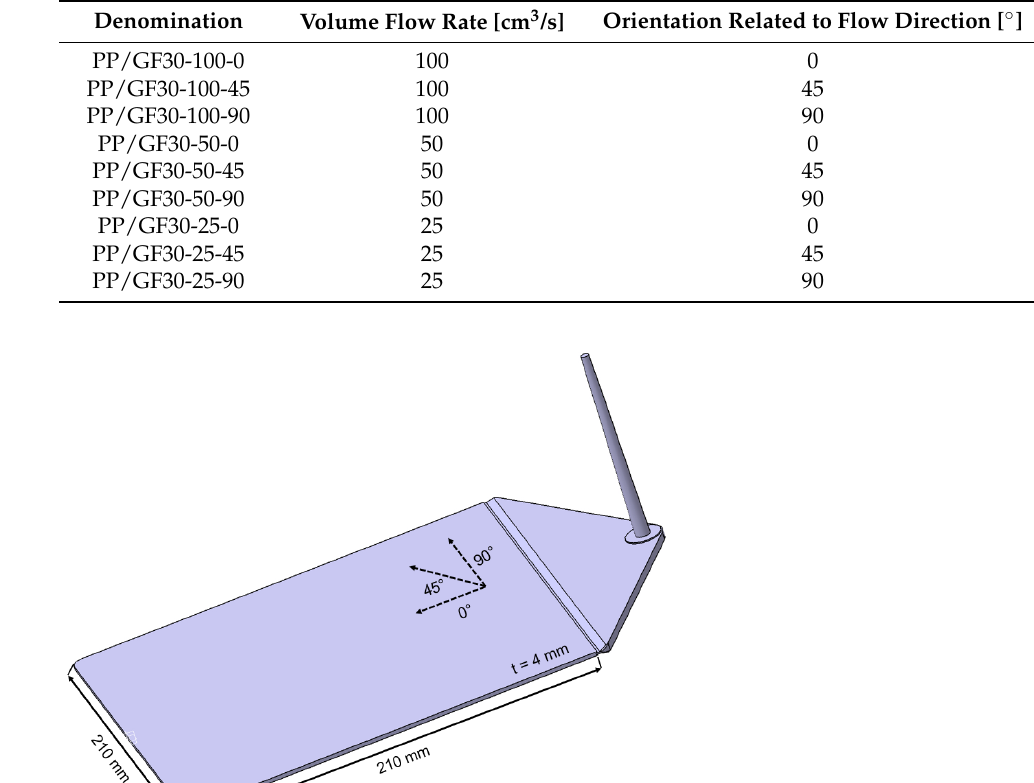
Table 3. Labeling of the analyzed test specimen of the PP/GF30 short fiber-reinforced thermoplastic composites and the corresponding volume flow rate and orientation related to flow direction due to injection molding and sample preparation from test plates, respectively.